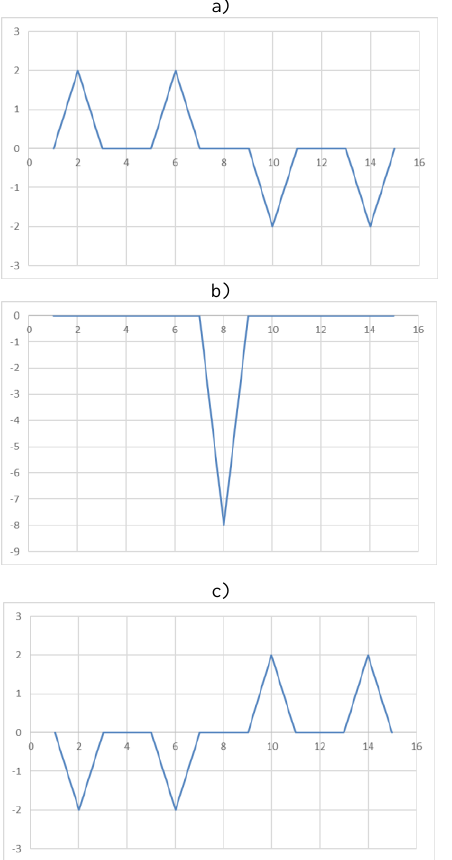
Fig. 11. CCFs with section length of i = 2 for the binary sequence and a sequence shifted by: a) 90°, b) 180°, c)